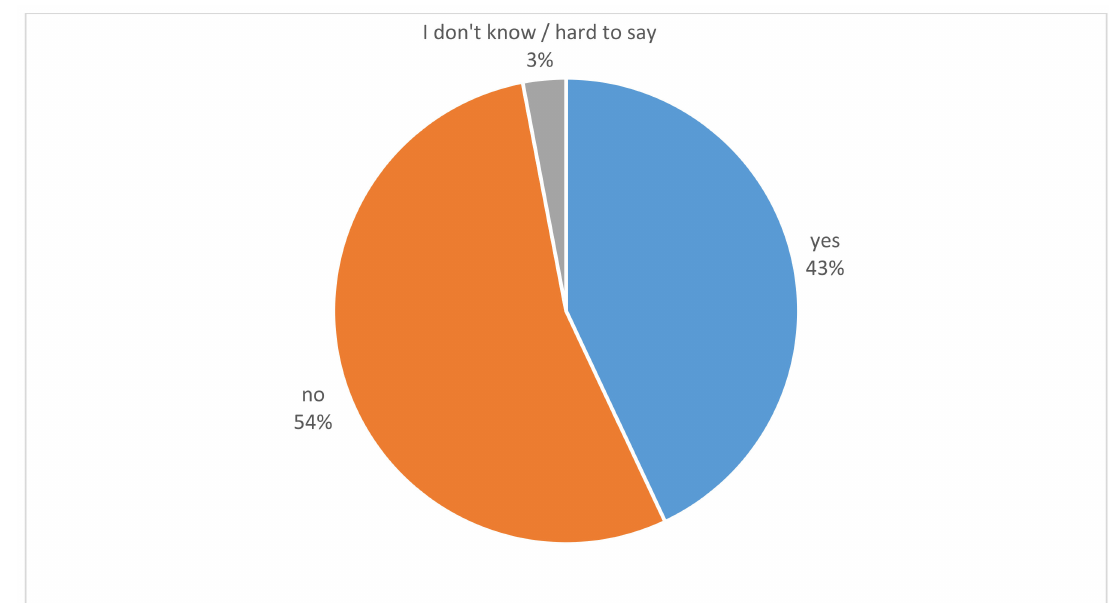
Figure 2. In the context of slogans about changes in energy policy, Poland as a country should think primarily about its national economic interest and not succumb to international pressure on this matter.